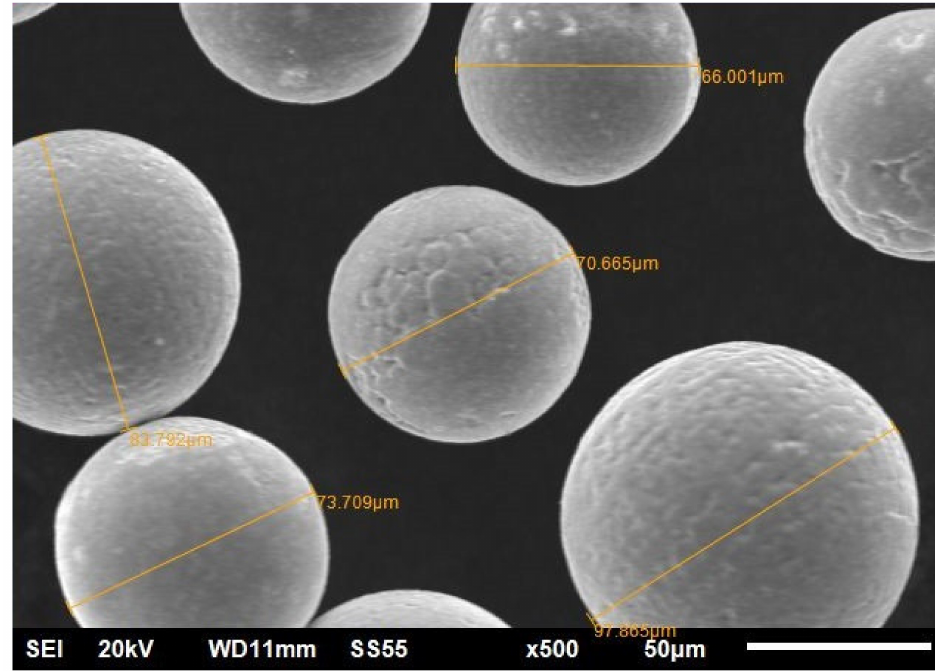
Figure 7. SEM secondary-electron image displaying the particle sizes of representative